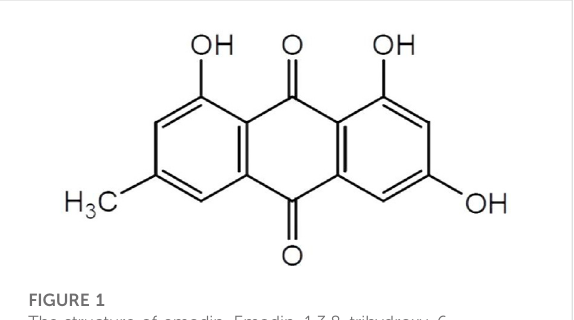
FIGURE 1 The structure of emodin. Emodin,